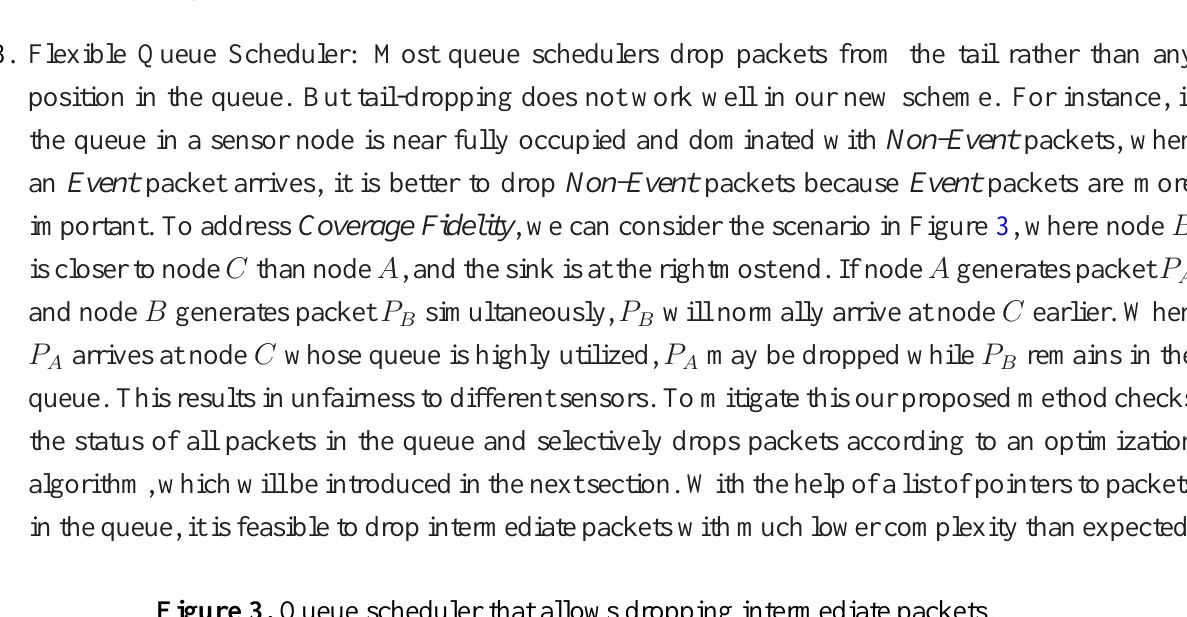
Figure 3. Queue scheduler that allows dropping intermediate